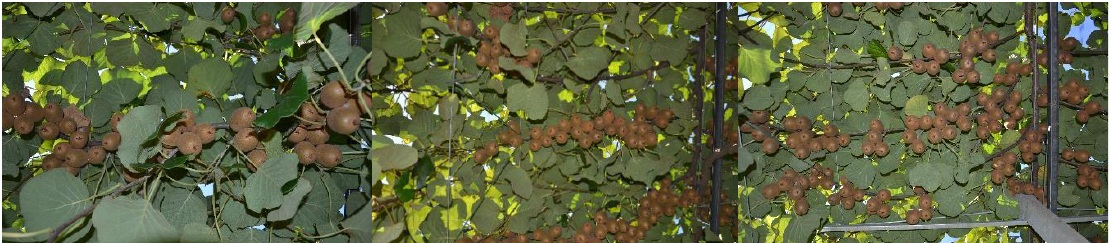
Figure 14. Image samples from the kiwifruit counting dataset.